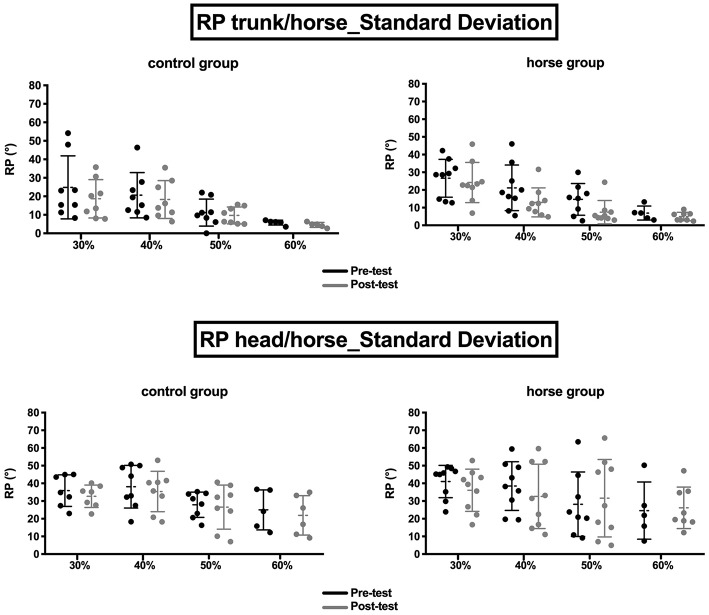
Relative phase variability (one point per patient; mean ± standard deviation) of trunk/horse (Top) and head/horse (Bottom) coordination, for the control (Left) and horse (Right) groups during pre-tests (in black) and post-tests (in gray), at each oscillation frequency.